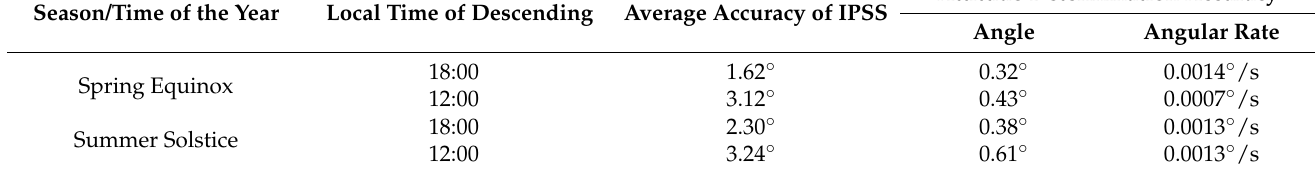
Table 4. Summary of the performance of the proposed IPSS in